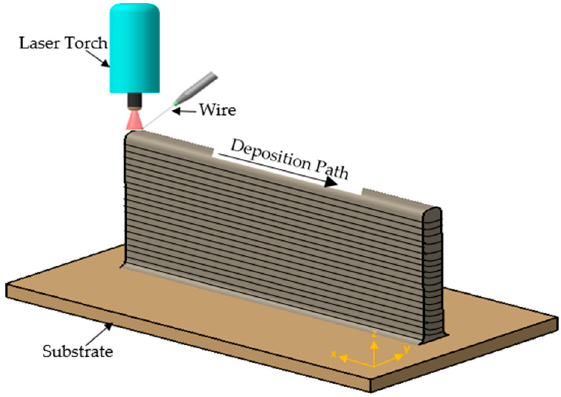
Figure 1. Graphical representation of the Wire Arc Additive Manufacturing (WAAM) process.